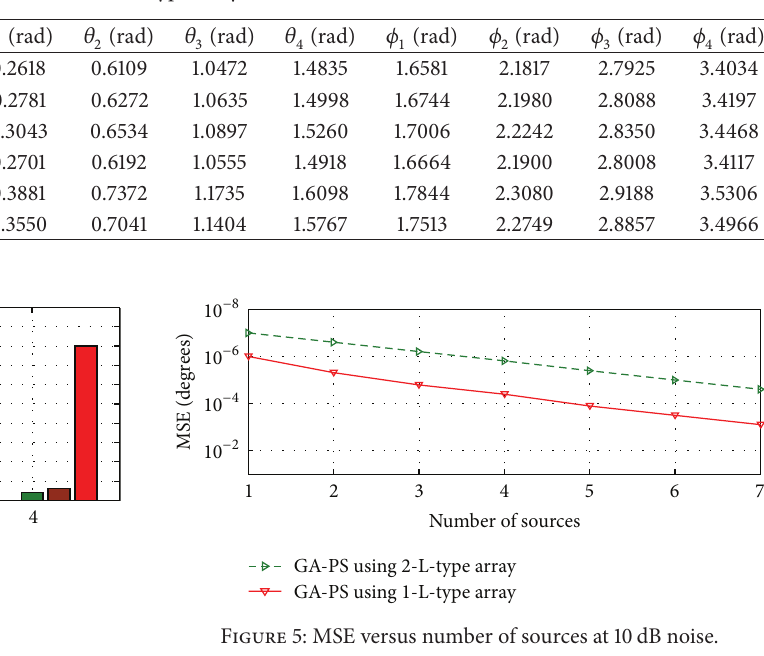
Table 7: Performance of 1-L-type array for 4 sources [15].